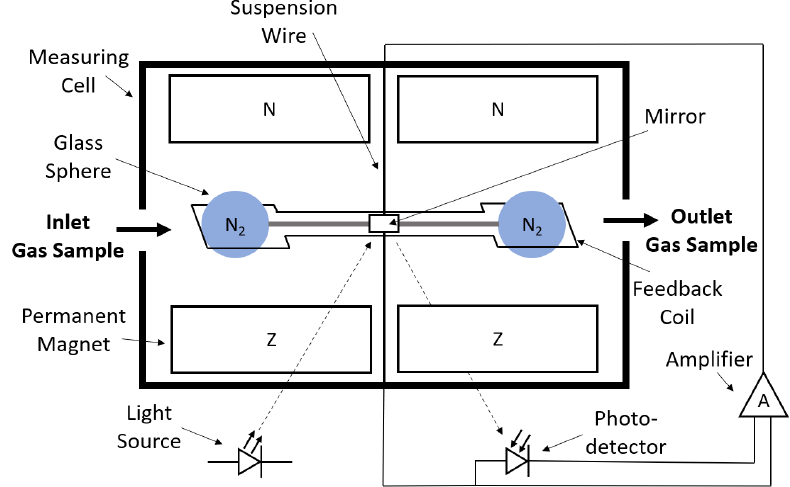
Figure 5. Schematic drawing of a paramagnetic oxygen sensor consisting of two glass spheres filled with N 2 , a permanent magnet, a mirror, a suspension wire, a feedback coil, a light source, and a photodetector with the bold arrows indicating the direction of gas flow and the dotted arrows indicating the direction of